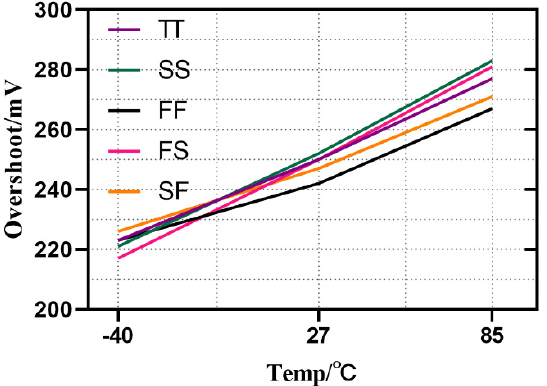
Figure 13. Overshoot against process corners and temperature variations.